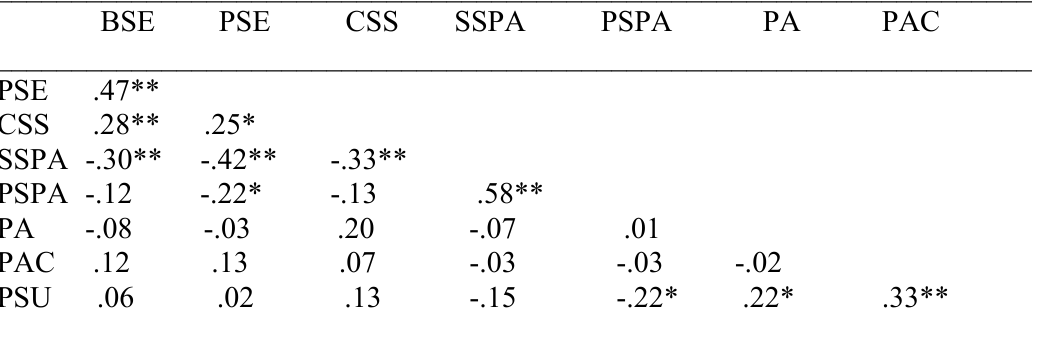
Table 2 Correlations among all Psychological Variables, PA, and